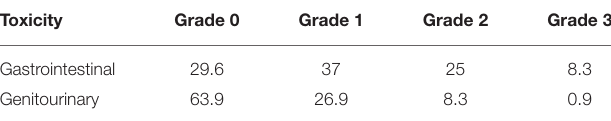
TABLE 5 | Incidence of treatment-related late toxicity